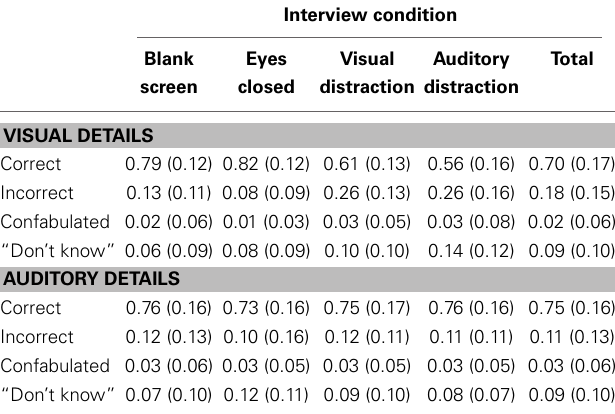
Table 1 | Mean proportions and standard deviations (in parentheses) of correct, incorrect, confabulated, and “don’t know” responses to questions about visual and auditory details in the four interview